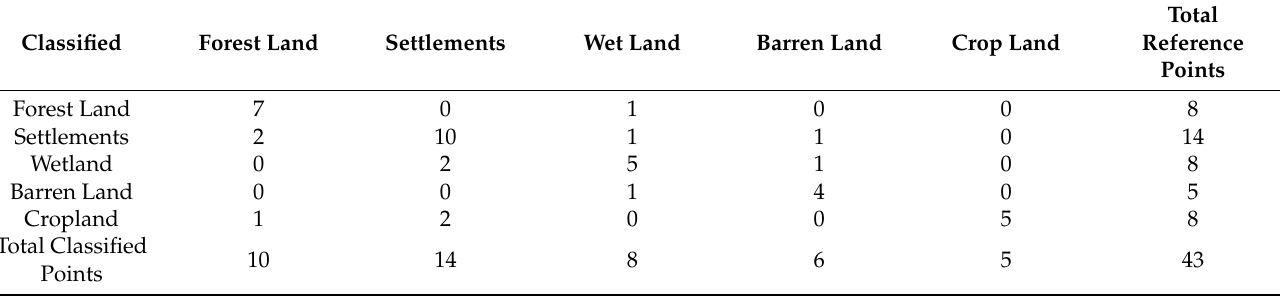
Table 2. Error matrix of 5 classes of